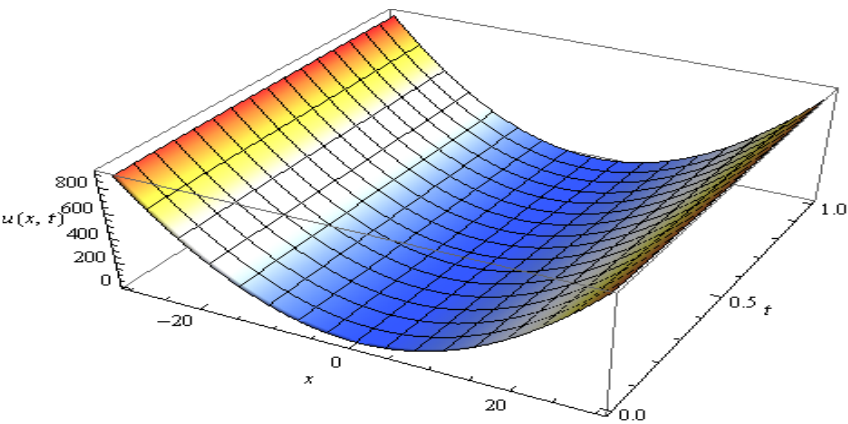
Figure 5. Ballistic-diffusion case of incompressible second grade fluid dynamics.